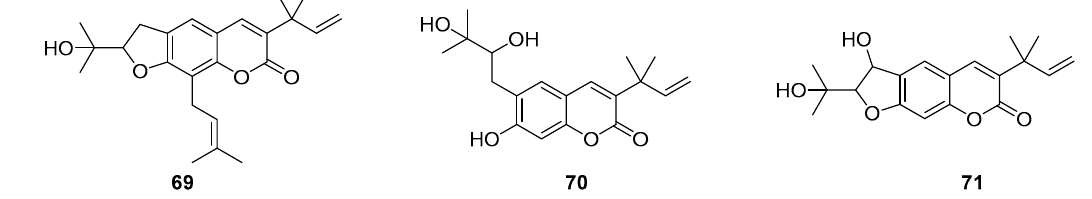
Figure 27. New prenylated coumarins from Clausena lenis .